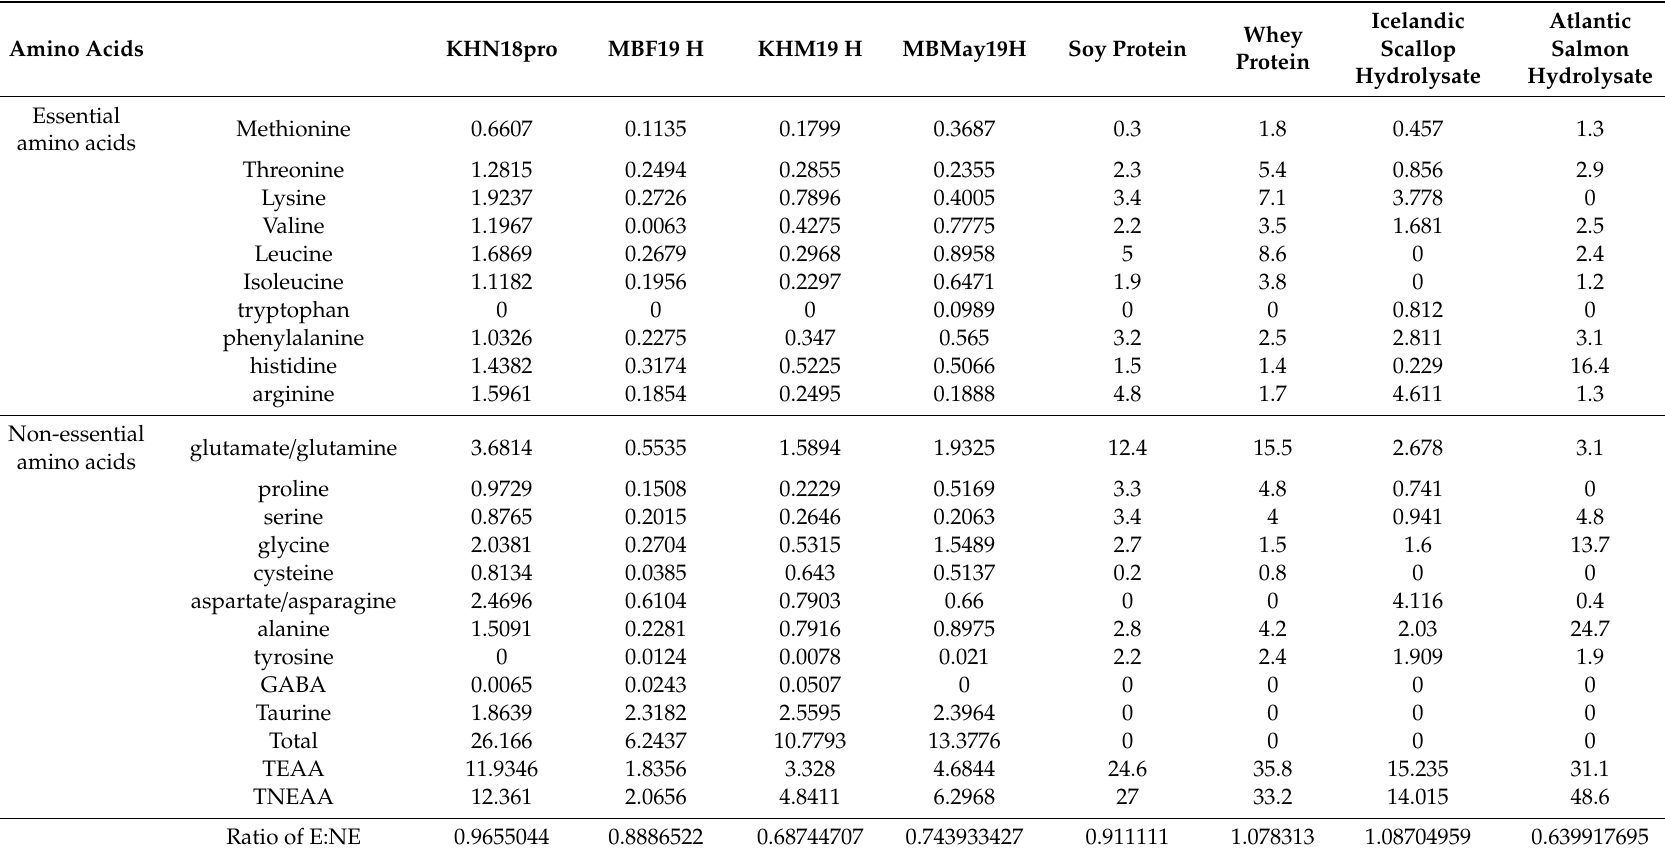
Table 2. Total amino acid composition (%, w / w ) of selected mussel by-product Protamex ® hydrolysates compared to other marine and non-marine protein hydrolysates.